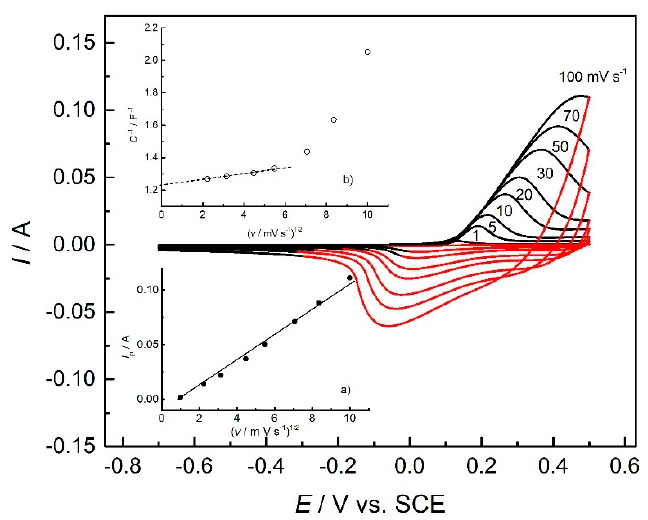
Figure 6. Cyclic voltammograms of the PANI electrode at different scan rates (as marked in the figure). Insert ( a ) the dependence of peak current on the square root of the scan rate and ( b ) the dependence of the reciprocal value of the capacitance on the square root of the scan rate.